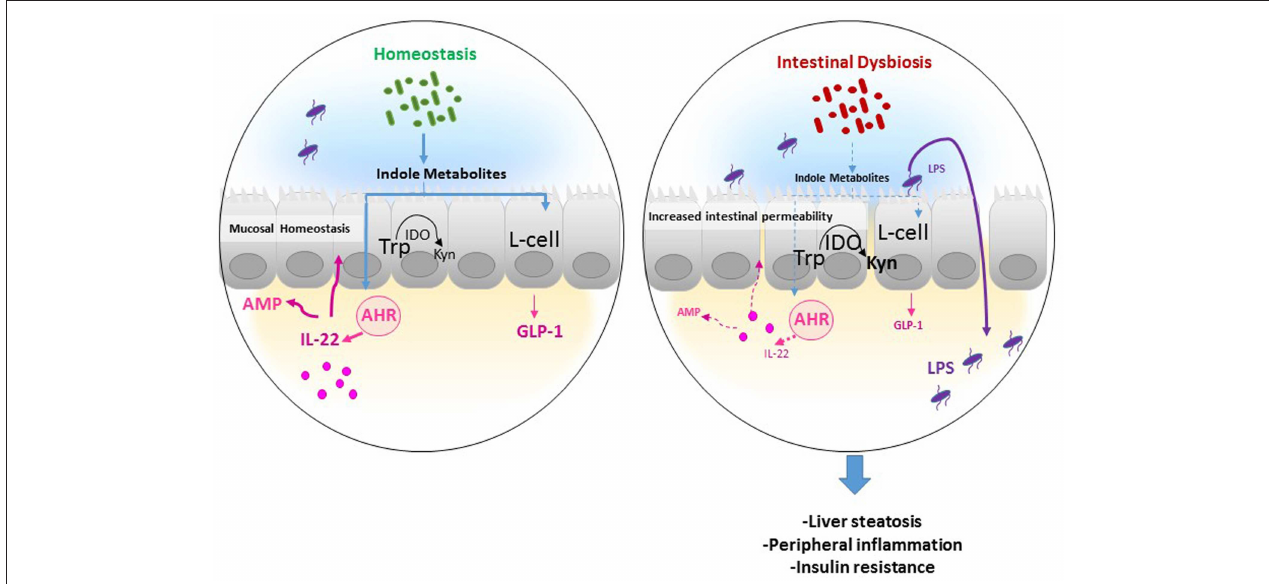
FIGURE 2 | Potential mechanism of actions of Trp metabolites in the gastrointestinal tract. In homeostatic condition, Tryptophan (Trp) is used by the host indoleamine 2,3-dioxygenase (IDO) to be converted to Kynurenine (Kyn), and by gut microbiota to produce indole metabolites. Several indole derivatives have been described as activators of the AHR that promotes IL-22 production, which stimulates mucosal defense via the induction of antimicrobial proteins (AMP). In addition, indoles may affect mucosal homeostasis by stimulating mucin production and promoting epithelial barrier function by enhancing tight junction proteins. Also, indoles induce the release of the incretin, glucagon-like peptide 1 (GLP-1), in enteroendocrine L cells, which is known to stimulate insulin secretion, suppress appetite, and inhibit gastrointestinal motility, and secretion. In an inflammatory disease condition such as obesity, the increase in IDO activity leads to decreased indole production from Trp and thus low GLP-1 and IL-22 production leading to increased intestinal permeability and lipopolysaccharide (LPS) translocation in the systemic circulation, resulting in peripheral inflammation, liver steatosis, and insulin